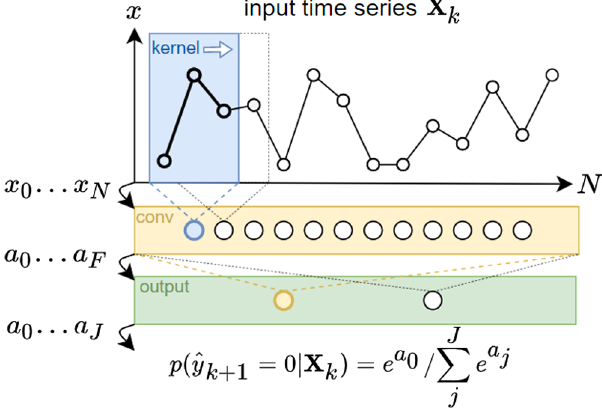
FIG. 9. Example of a convolutional neural network (CNN) for time-series prediction. For simplicity, the input X consists of k only one signal, i.e., m ¼ 1 , and the network consists of only one hidden convolutional (conv) layer. As in most of our models, the softmax activation function is used as an output to derive X f ð X p ð ˆ y out of the activations a . In this example, k Þ ¼ k þ 1 j k Þ j the kernel size of the convolution layer is 3, the filter size is F ¼ 12 , and the probability of a breakdown in the next pulse 0 ), is stated. In this case, the network would have 60 ( y k þ 1 ¼ trainable